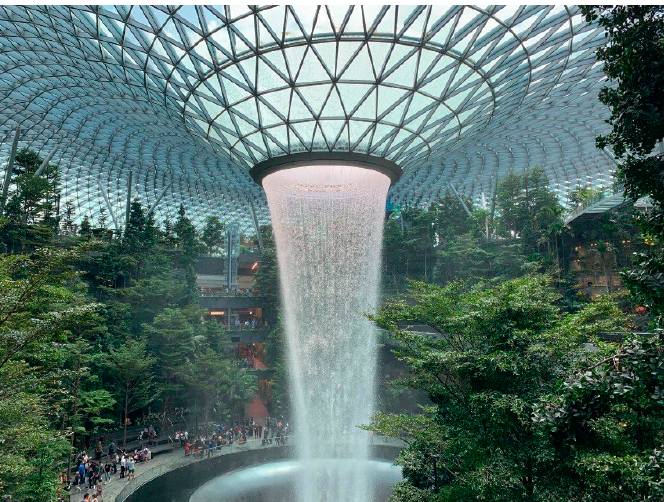
Figure 1. Central opening of Changi